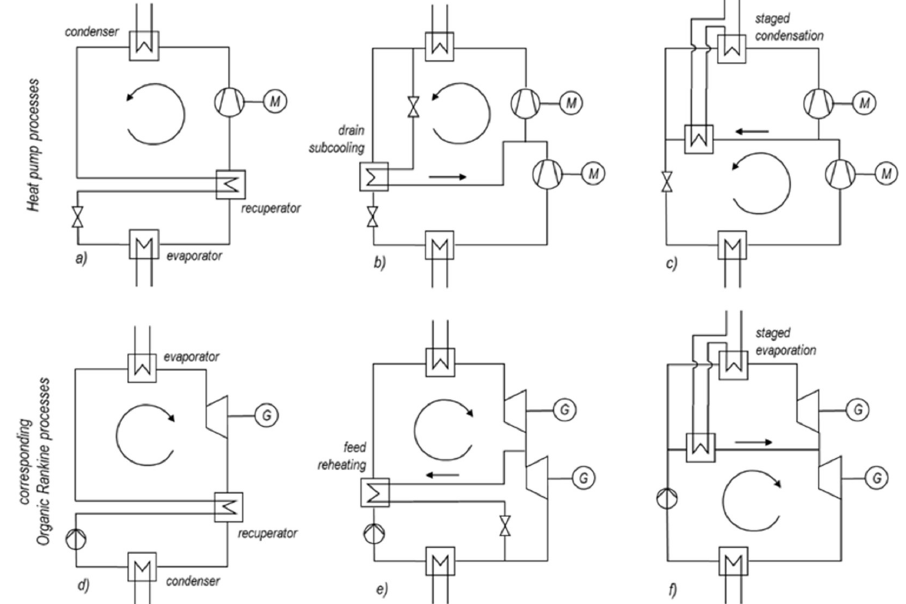
Figure 7. Principles for the optimization of heat pump and Rankine Cycles through the preheat of the heat pump’s compressor feed and the preheat of the ORC’s evaporator feed by means of: ( a , d ) a recuperator, process layout; ( b , e ) a split stream from the compressor and turbine, process layout and ( c , f ) staged condensation and evaporation, process layout.